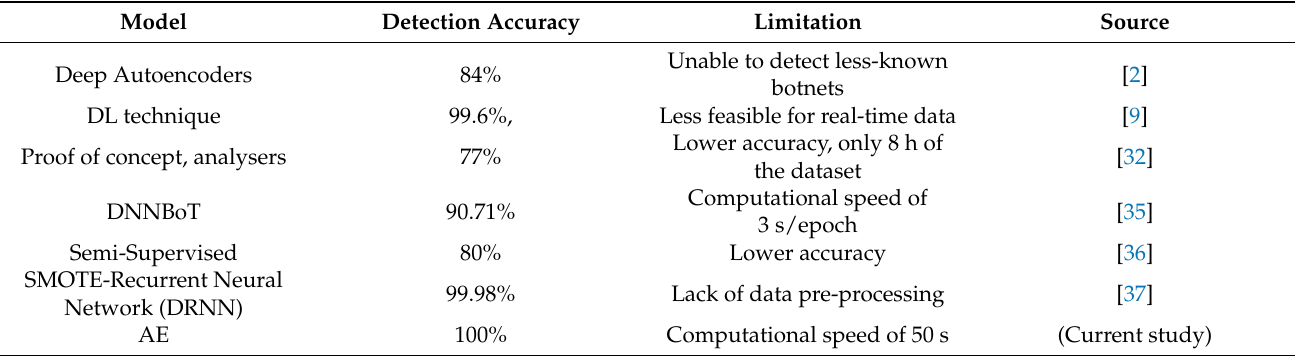
Table 6. Comparison of AE-based botnet detection used in the present investigation with other